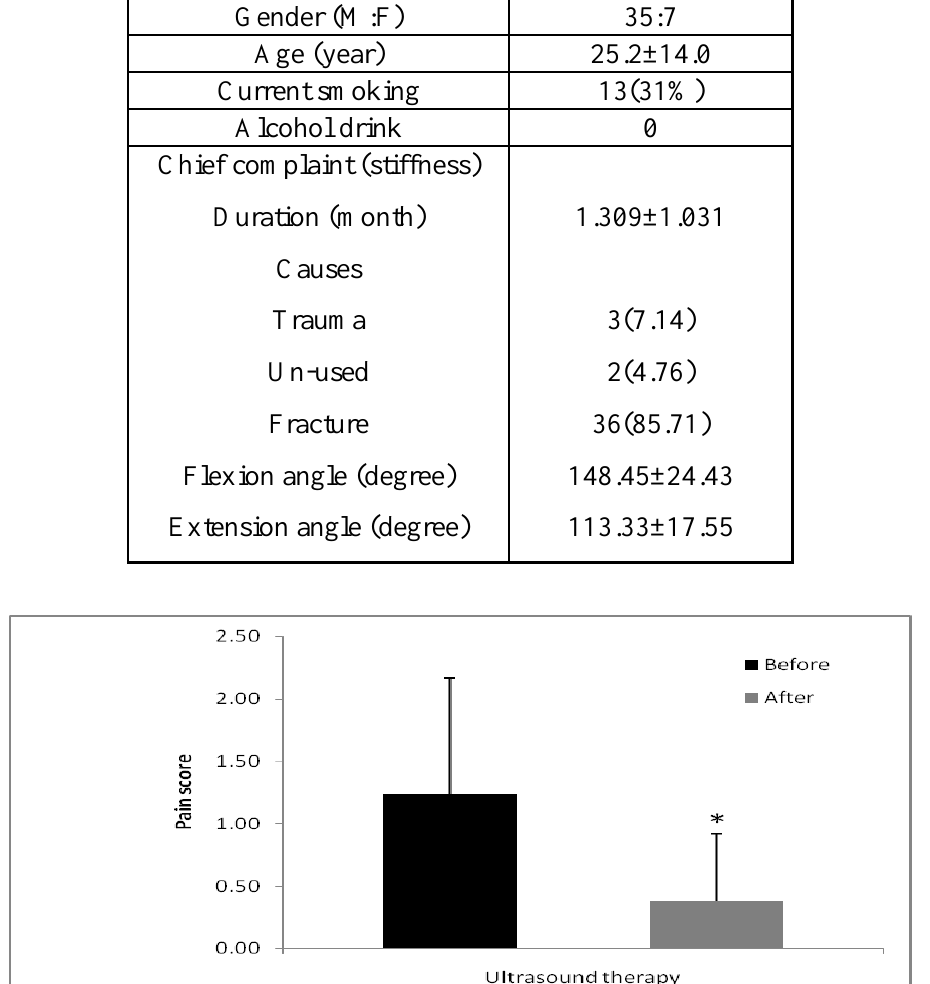
Table 1: Characteristics of the study.